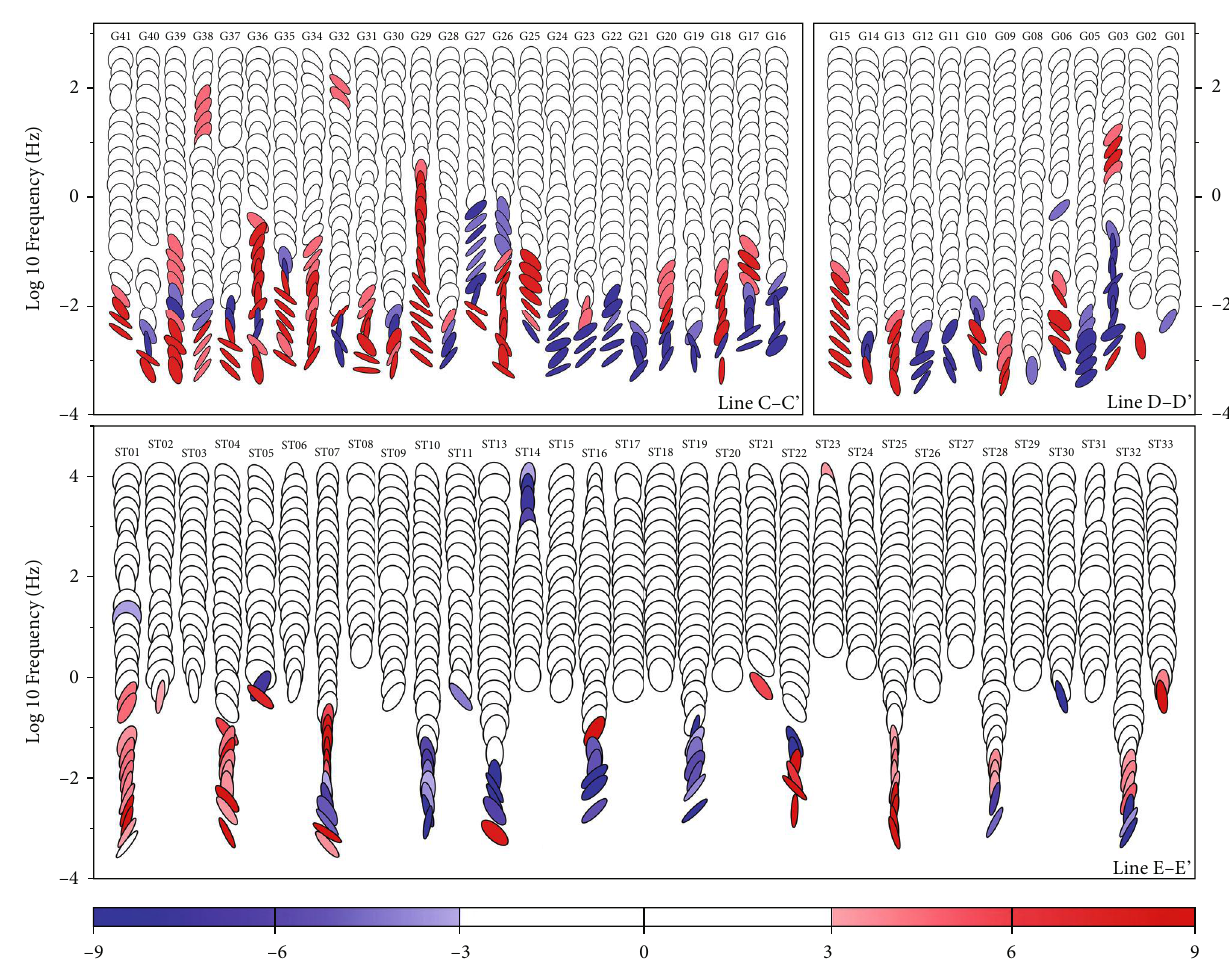
Figure 4: Dimensionality analysis based on skew angle ( β ) from the phase tensor analysis [39] for MT data in line C-C ′ , D-D ′ , and E-E ′ (see Figure 2 for MT pro fi le lines and sounding